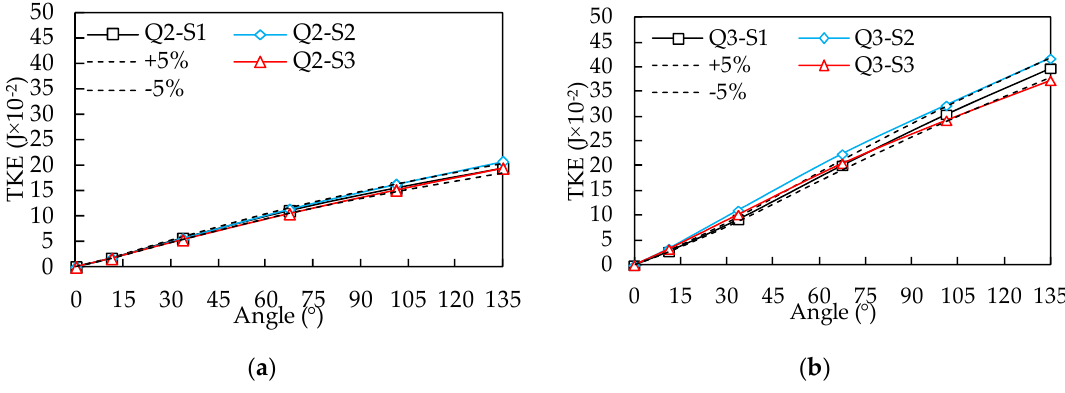
Figure 13. Distribution of TKE in the back bend of the water body: ( a ) Distribution of TKE at Q2, ( b ) Distribution of TKE at Q3. The black dotted line is the 5% variation amplitude line of